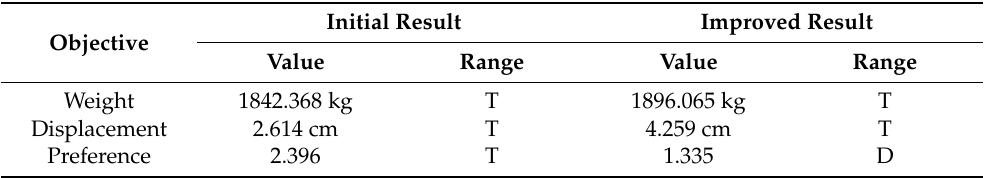
Table 11. Objective information for the second